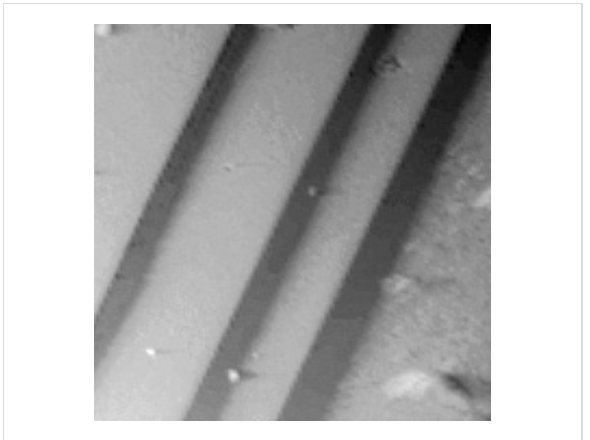
Figure 2: Contact mode AFM topograph of the V 4 O 7 crystal cleavage plane. Scanning size: 25 × 25 µm 2 , z -range 1 µm.